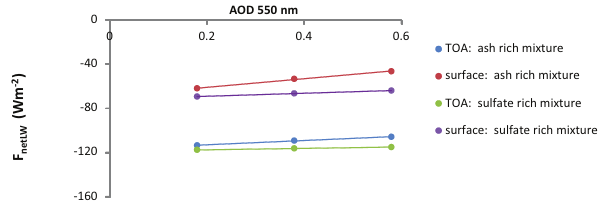
Fig. 9. The relationship between net LW flux and AOD(550 nm) at an AOD range of 0.18–0.58 for two aerosol mixtures at the TOA and surface. The R 2 regressions for all lines are greater than